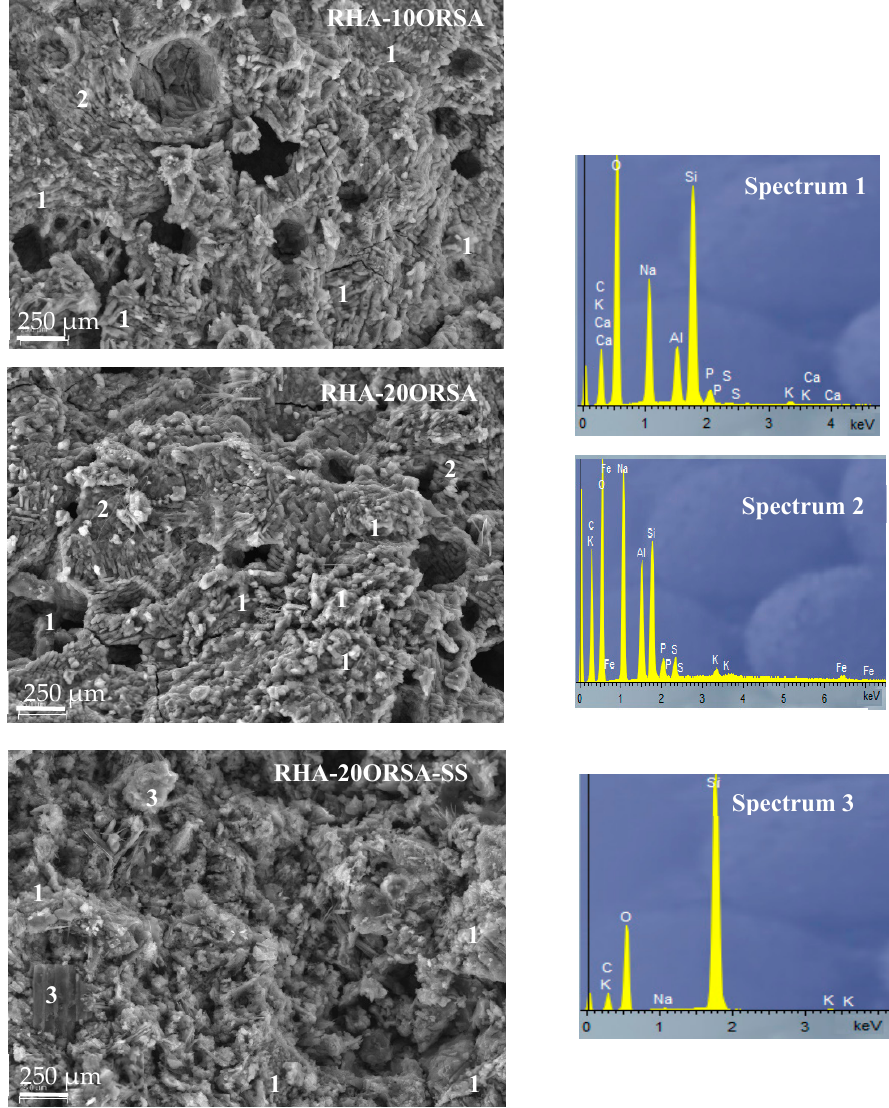
Figure 9. SEM micrographs-EDX analysis of RHA-10ORSA, RHA-20ORSA and RHA-20ORSA-SS geopolymers.